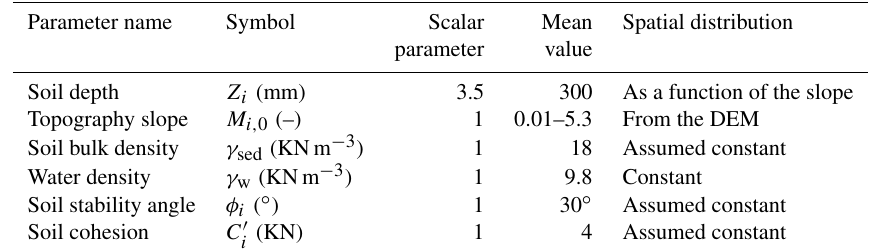
Table 4. Landslide model parameters.